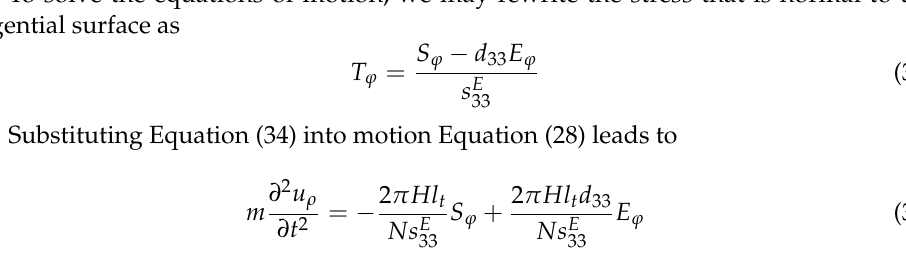
is the dielectric constant of 33